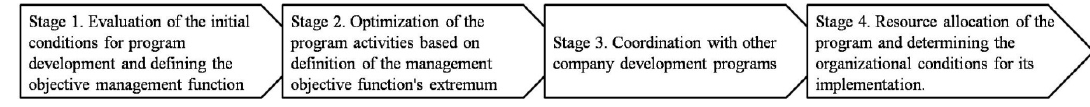
Figure 4. The main stages of building the program of energy saving and energy efficiency improvement of the company in the context of its innovative development (source: compiled by the authors).